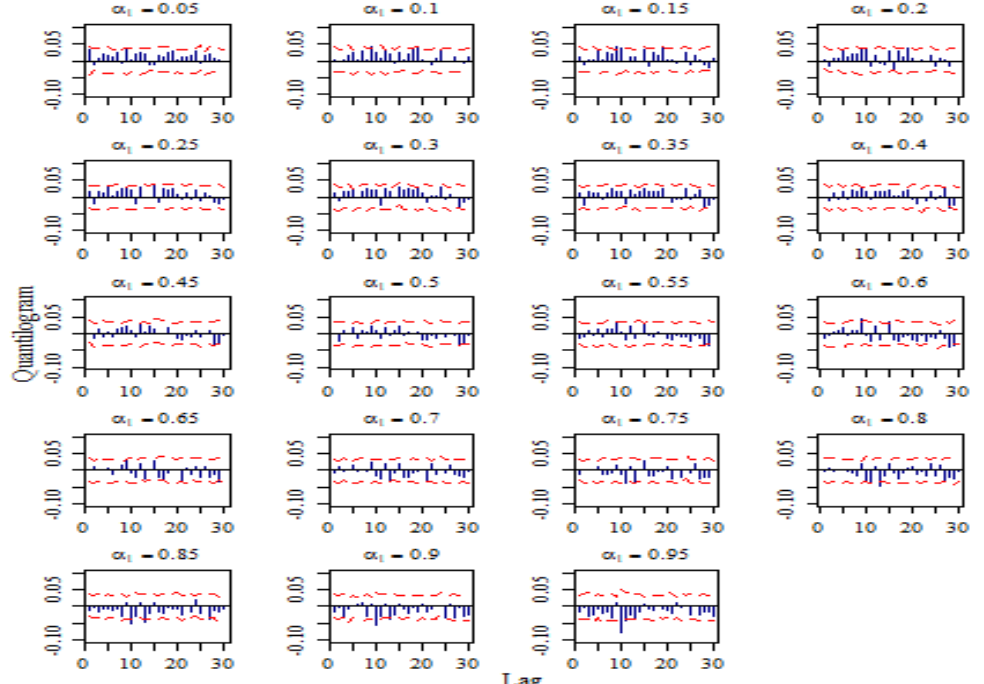
for 𝑞𝑞 2 ( 𝛼𝛼 2 ) 𝛼𝛼 2 =